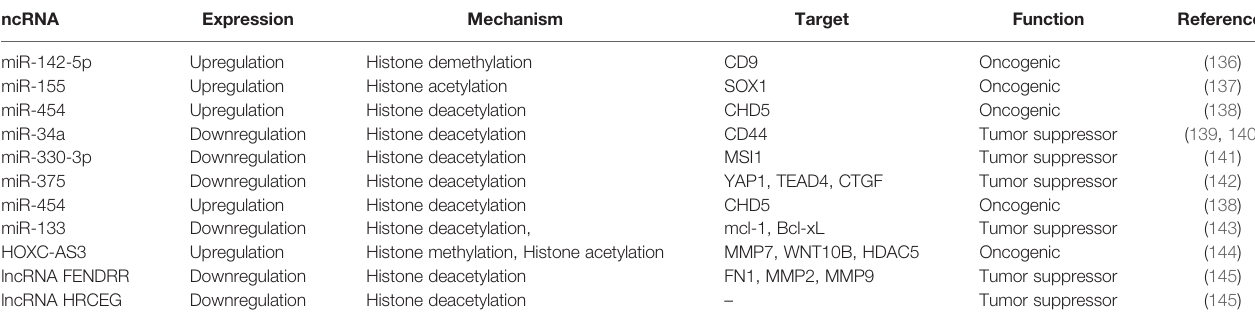
TABLE 3 | ncRNAs regulated by histone modi fi cation in